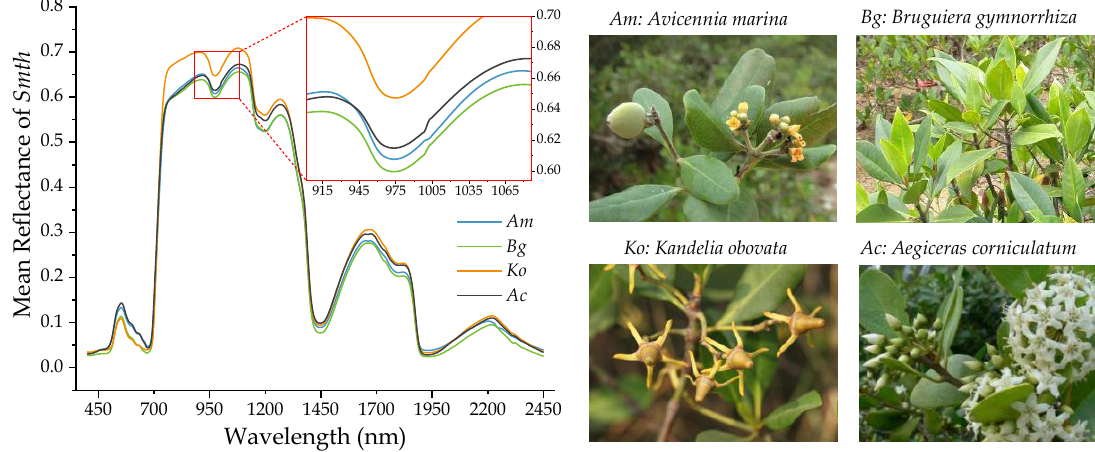
Figure 2. The mean smooth ( Smth ) reflectance spectrum and photos of four mangrove species.